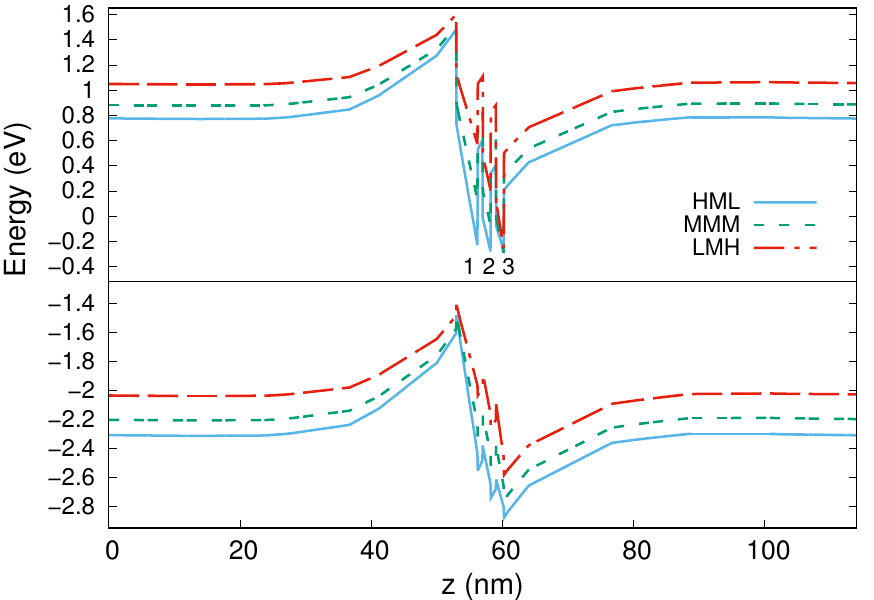
Figure 3. Conduction ( top ) and valence ( bottom ) band structures along vertical z -axis. Wells 1, 2, and 3 correspond to QD1, QD2, and